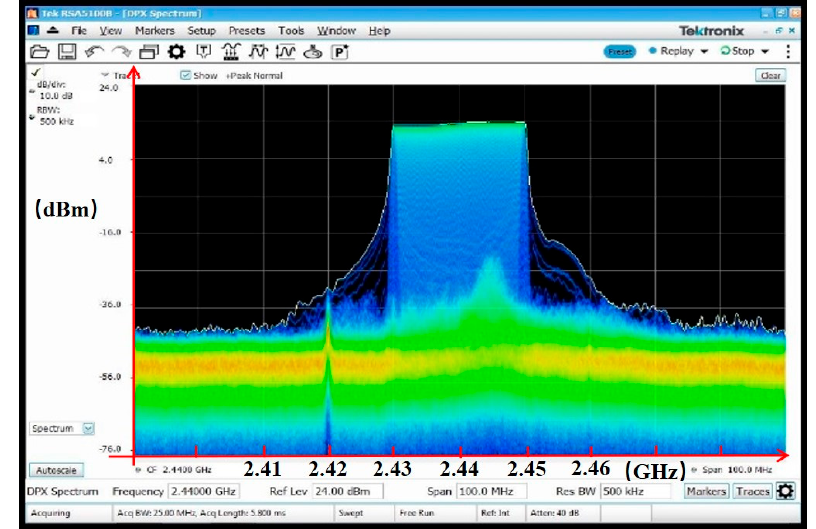
Figure 5. The DPX spectrum of magnetron.